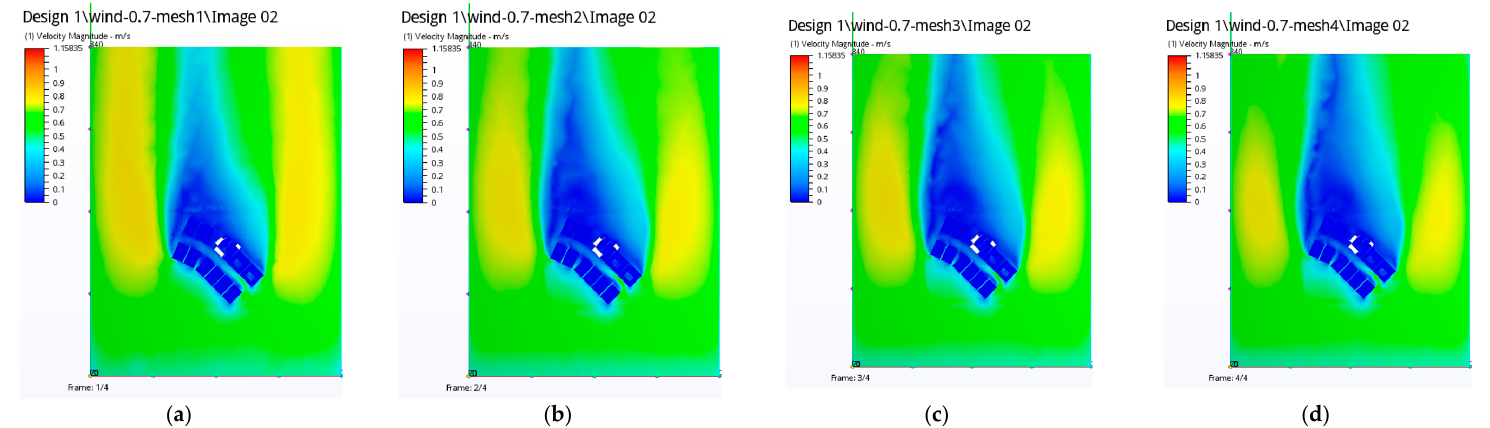
Figure 10. Mesh configurations and wind velocity magnitude plan contours: ( a ) Mesh 1, ( b ) Mesh 2 , ( c ) Mesh 3, and ( d ) Mesh 4.